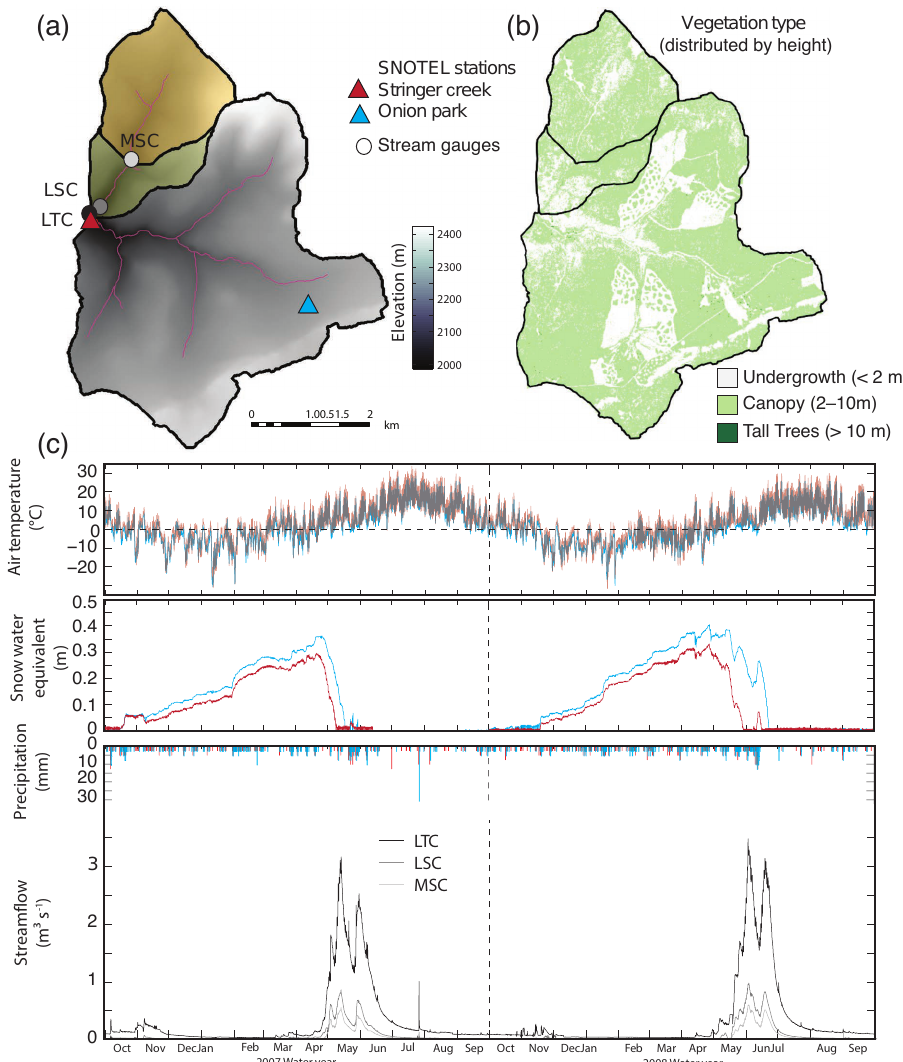
Figure 1. Tenderfoot Creek Experimental Forest (a) digital elevation model (DEM) and instrumentation used in the study and (b) vegetation type used by DHSVM to distribute model parameters. (a) Instrumentation includes a streamflow calibration station at the outlet of Stringer Creek (LSC) as well as streamflow gaging stations at the outlet of Tenderfoot Creek (LTC) and middle Stringer Creek (MSC). Most forcing data are measured at SNOTEL sites Stringer Creek and Onion Park. Water balance time series are extracted at both SNOTEL locations, as well as streamflow behavior at the Stringer Creek outlet. (b) Vegetation type is distributed based on vegetation height, with cells with undergrowth vegetation shown in white, cells with canopy vegetation shown in light green, and cells with tall tree vegetation shown in dark green. (c) The model is forced with air temperature and precipitation data collected at the two SNOTEL locations. Catchment observations include snow water equivalent at two SNOTEL sites and streamflow at three